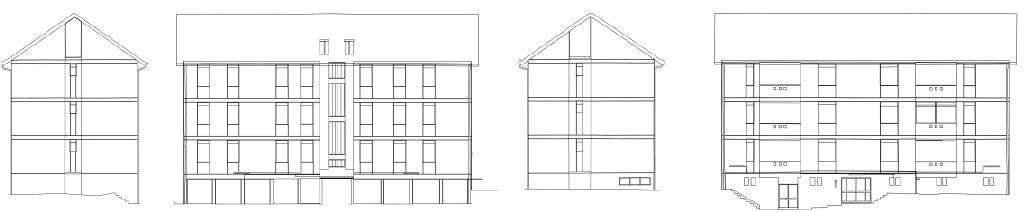
Figure 4. Technical drawings of the building façades before the retrofitting.